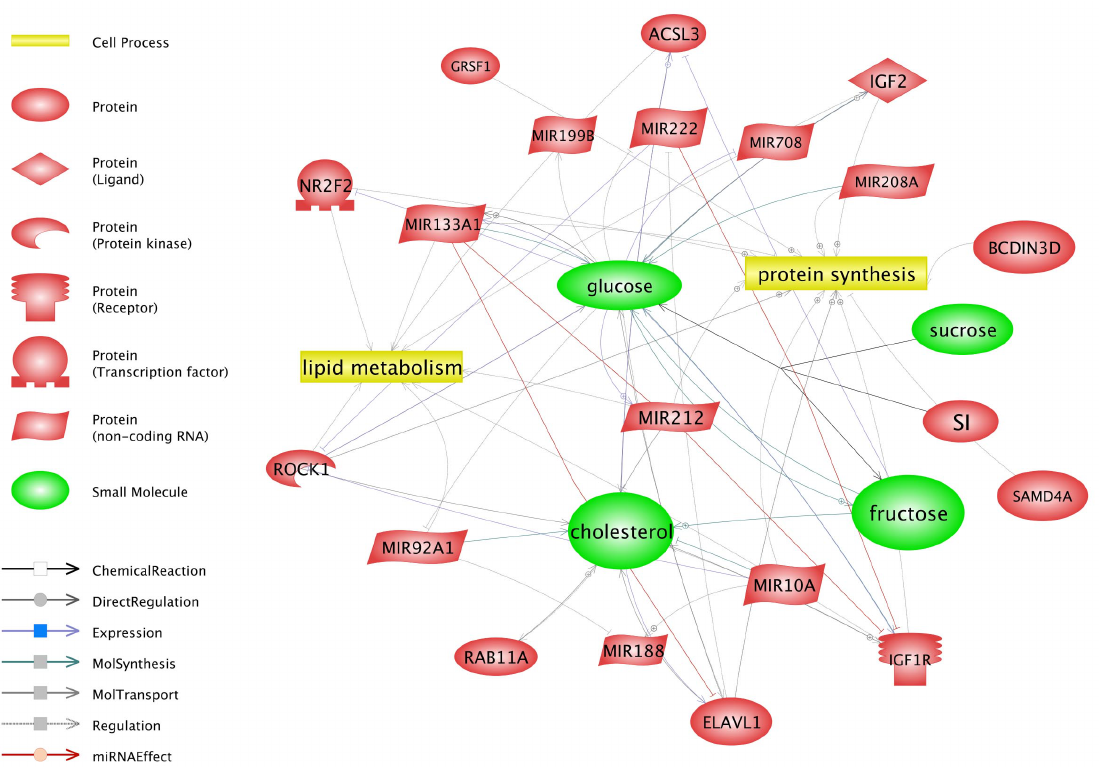
Figure 7. Relationships between differentially expressed genes, selected miRNAs and metabolic